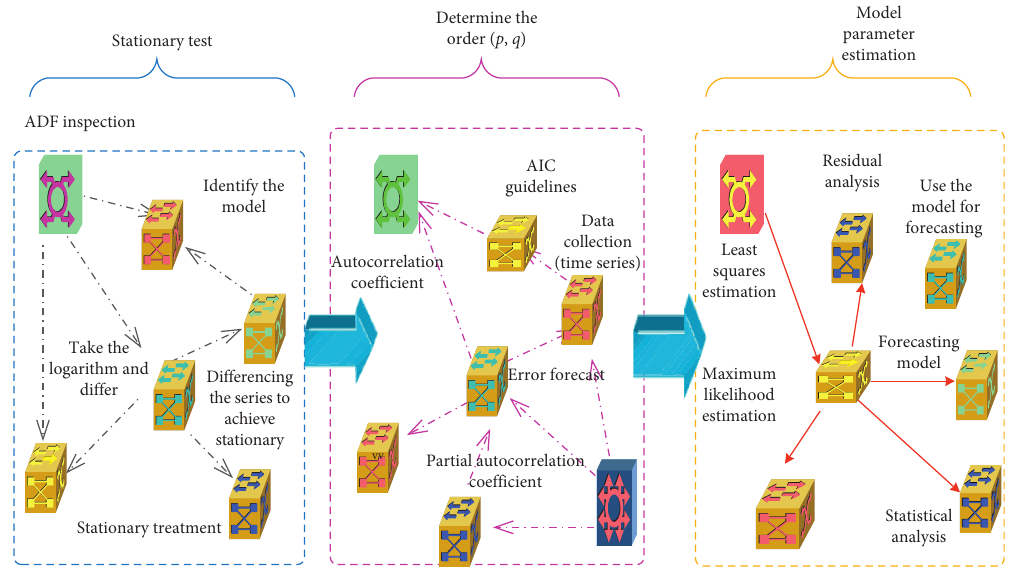
Figure 2: Schematic diagram of ARIMA model modeling